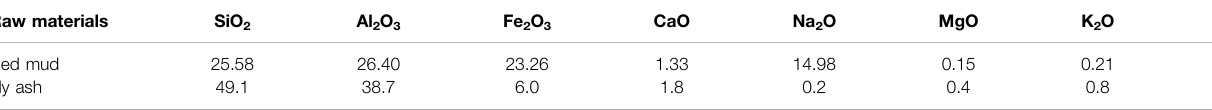
TABLE 1 | Chemical composition of fl y ash and red mud. Raw materials